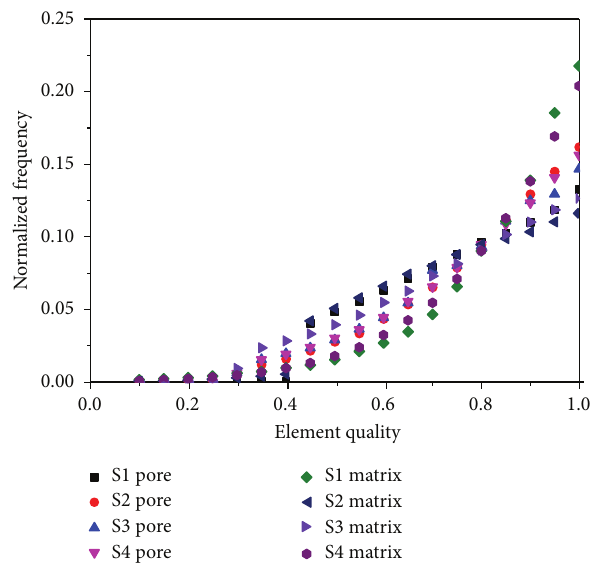
Figure 4: Element quality of reconstructed FEM